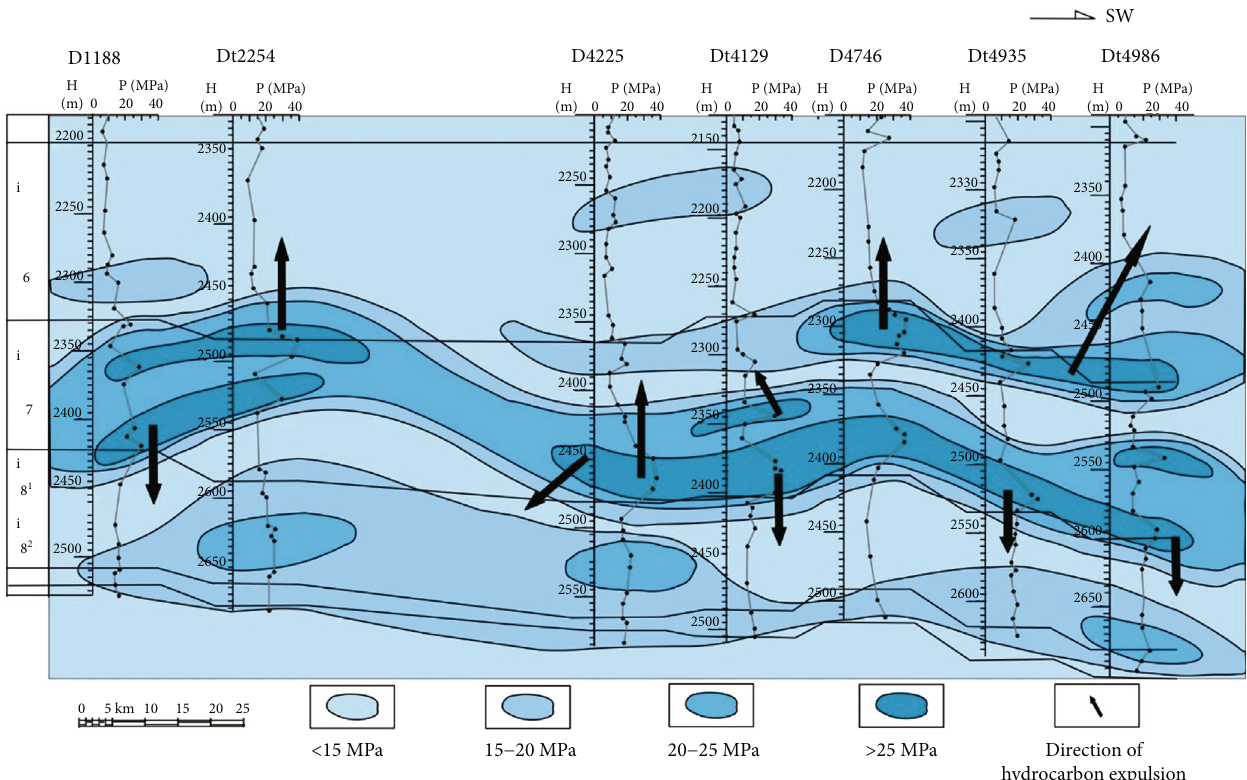
Figure 7: Residual pressure pro fi les of well Ding1188-well D ingtan4986 of Yanchang Group in. Wuqi-Dingbian. Table 2: Relationship between the number of commercial oil wells of C8-C10 and the distance of C7. Distance to C7 bottom